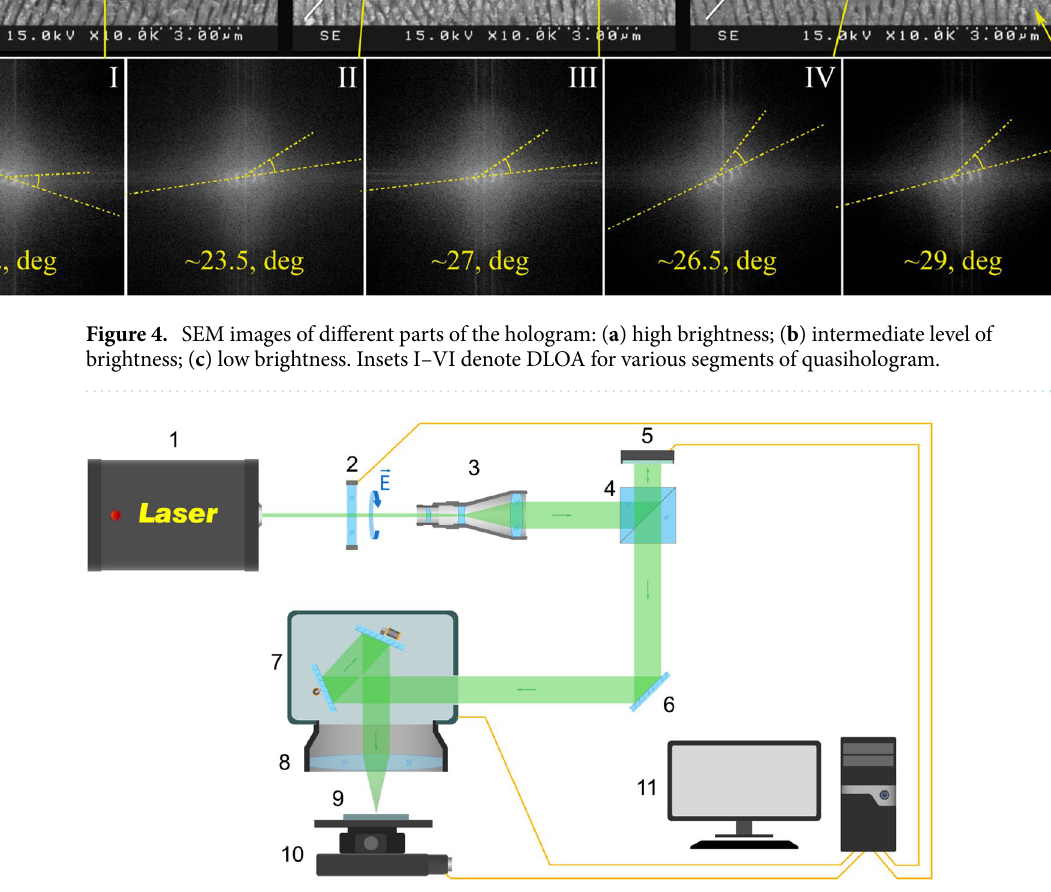
Figure 5. Optical scheme of hologram recording: laser (1), half-wave plate (2), beam expander (3), beam- splitting cube (4), spatial light modulator (5), mirror (6), galvo scanner (7), F- Theta lens (8), sample (9), six- axis positioner (10), PC